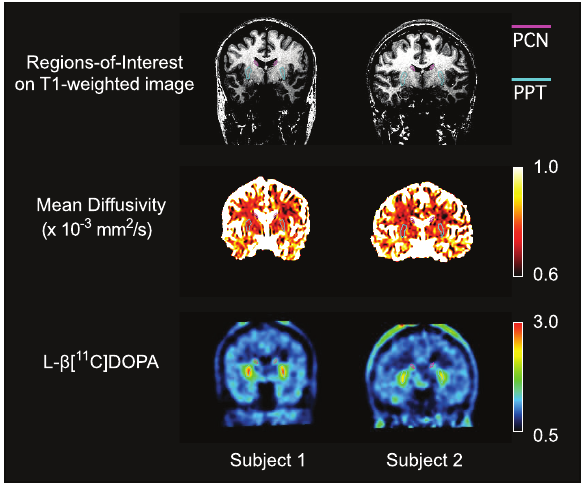
Figure 4. Typical images for subjects with high and low mean diffusivity (subjects 1 and 2, respectively) and corresponding mean diffusivity images. Regions of interest on T1-weighted images for posterior caudate and putamen (PCN and PPT) are also shown.